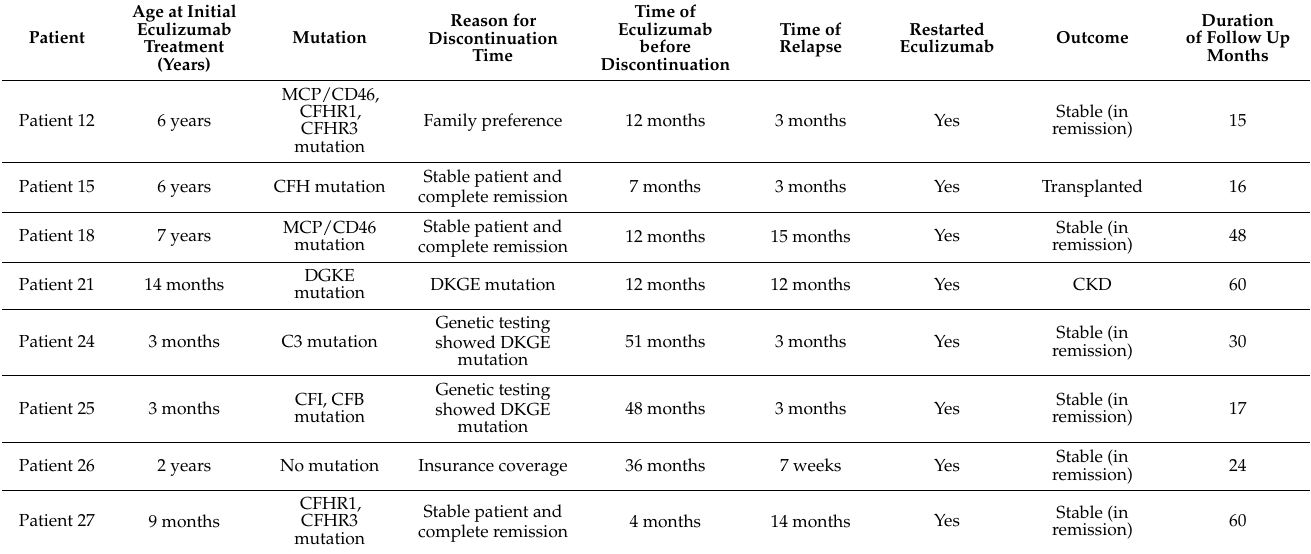
Table 5. The individual characteristics and outcomes of 8 patients who experienced aHUS